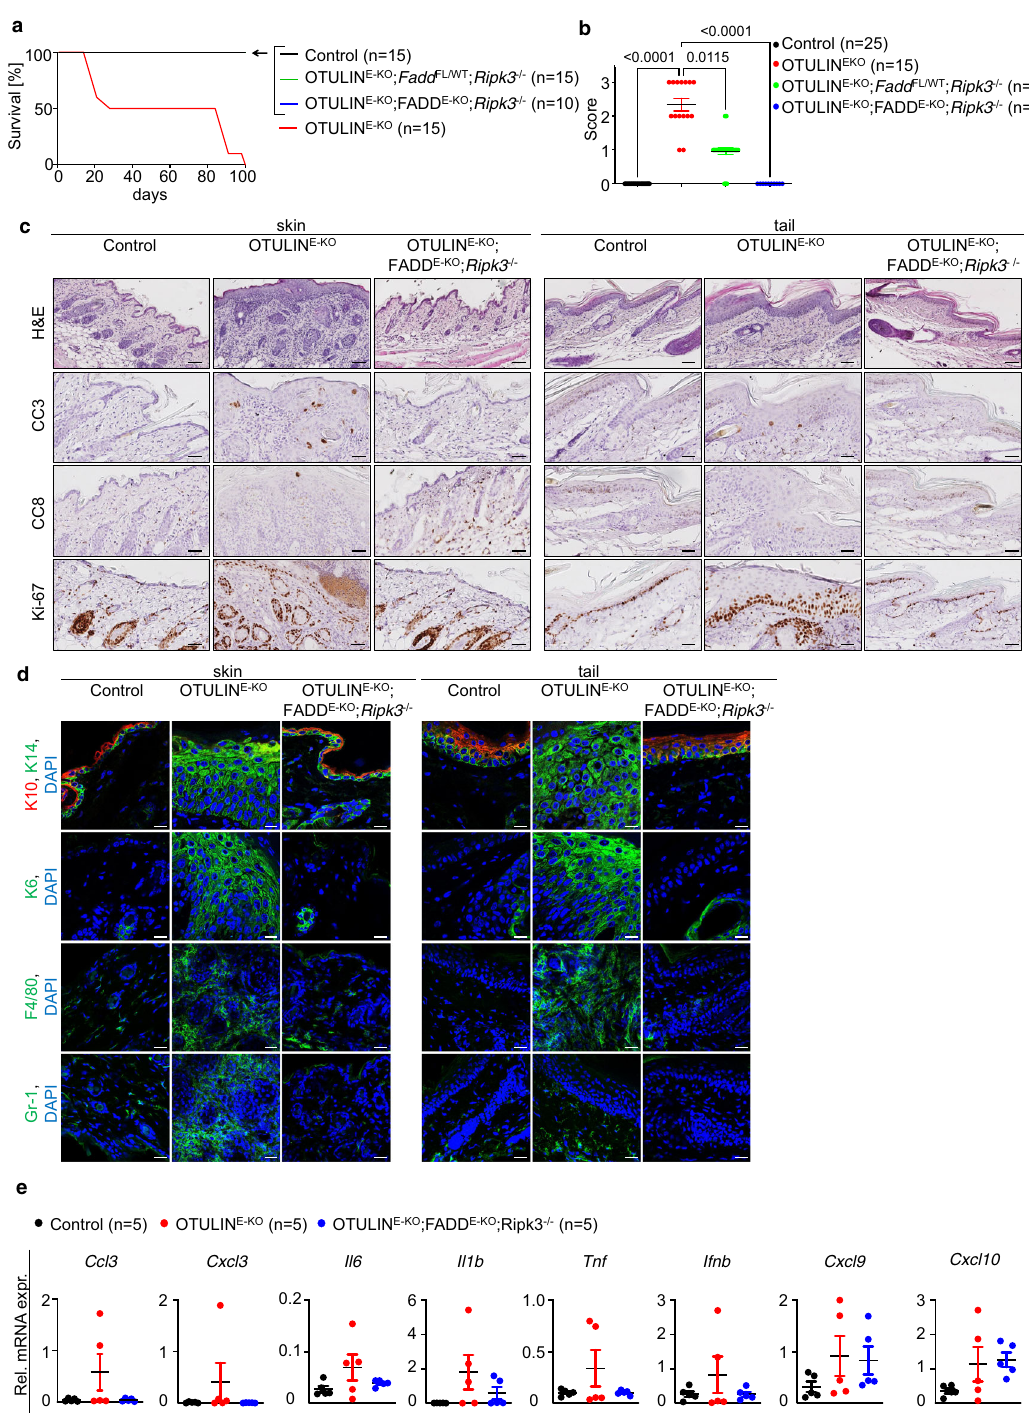
Fig. 7 Combined ablation of FADD and RIPK3 fully prevents skin lesion development in OTULIN E-KO mice. a Kaplan – Meier plot depicting survival of mice of the indicated genotypes. b Graph depicting macroscopic skin score of mice of the indicated genotypes. The dots in the graphs represent individual mice. Mean ± s.e.m. is shown for each group of mice in all graphs. Statistical signi fi cance was determined using Kruskal – Wallis test (one-sided). c Representative images of skin sections from 3-week-old mice of the indicated genotypes, stained with H&E ( n = 6) or immunostained with anti-CC3 ( n = 4), anti-CC8 ( n = 4) or anti-Ki-67 ( n = 3) antibodies. Scale bar H&E = 100 μ m; CC3, CC8, Ki-67 = 50 μ m. d Representative images from skin sections from 3-week-old mice of the indicated genotypes ( n > 5), immunostained with anti-K10, anti-K14 ( n = 4), anti-K6 ( n = 4), anti-F4/80 ( n = 3) and anti-Gr-1 ( n = 3) antibodies and counterstained with DAPI (DNA stain). Scale bar K10, K14, K6 = 20 μ m; F4/80, Gr-1 = 30 μ m. e Graphs depicting relative mRNA expression of the indicated genes in RNA from whole-skin tissue of 3-week-old mice of the indicated genotypes, measured by qRT-PCR. The dots in the graphs represent individual mice. Mean ± s.e.m. is shown for each group of mice in all graphs. Statistical signi fi cance was determined using Kruskal – Wallis test (one-sided). Control mice include littermates that do not express K14-Cre . Source data for a , b , e are provided as a Source data fi